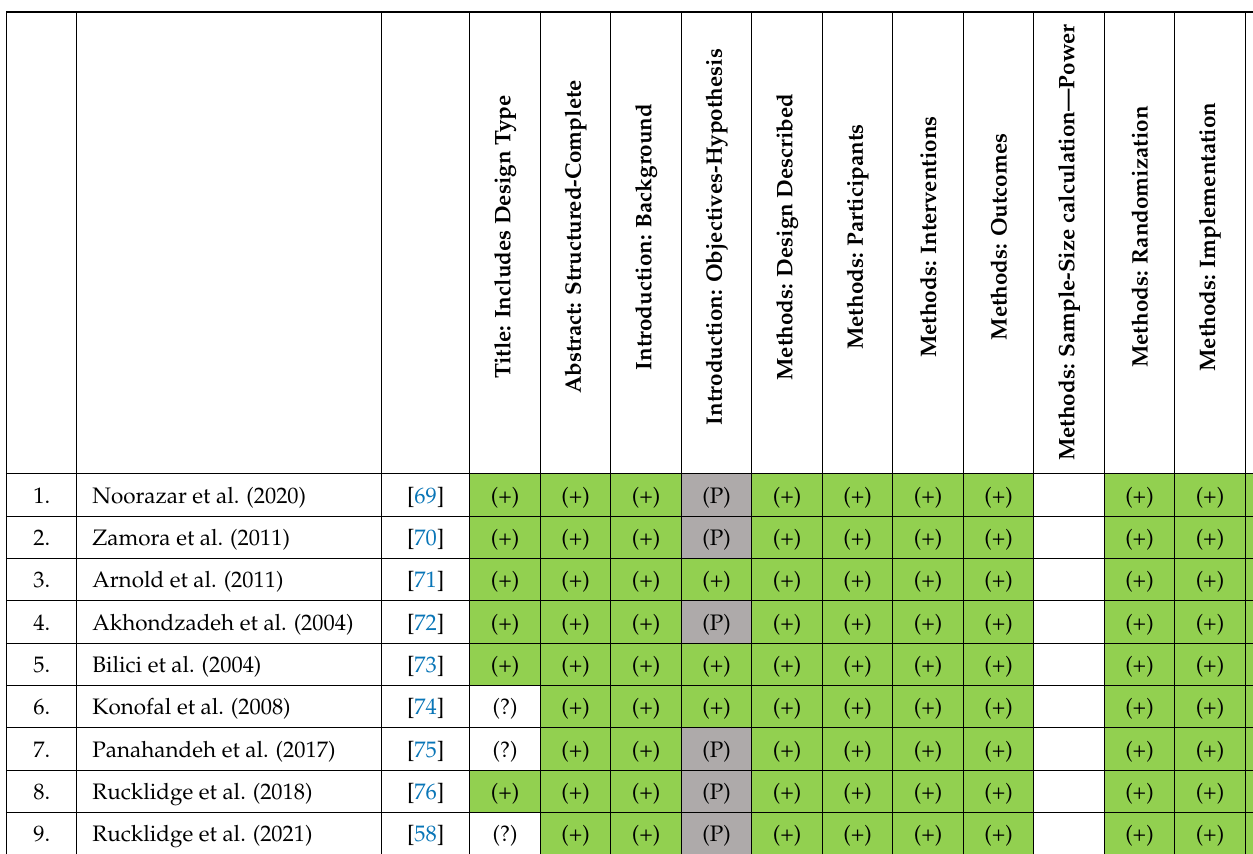
Table 2. Assessment of the studies’ quality based on the CONSORT